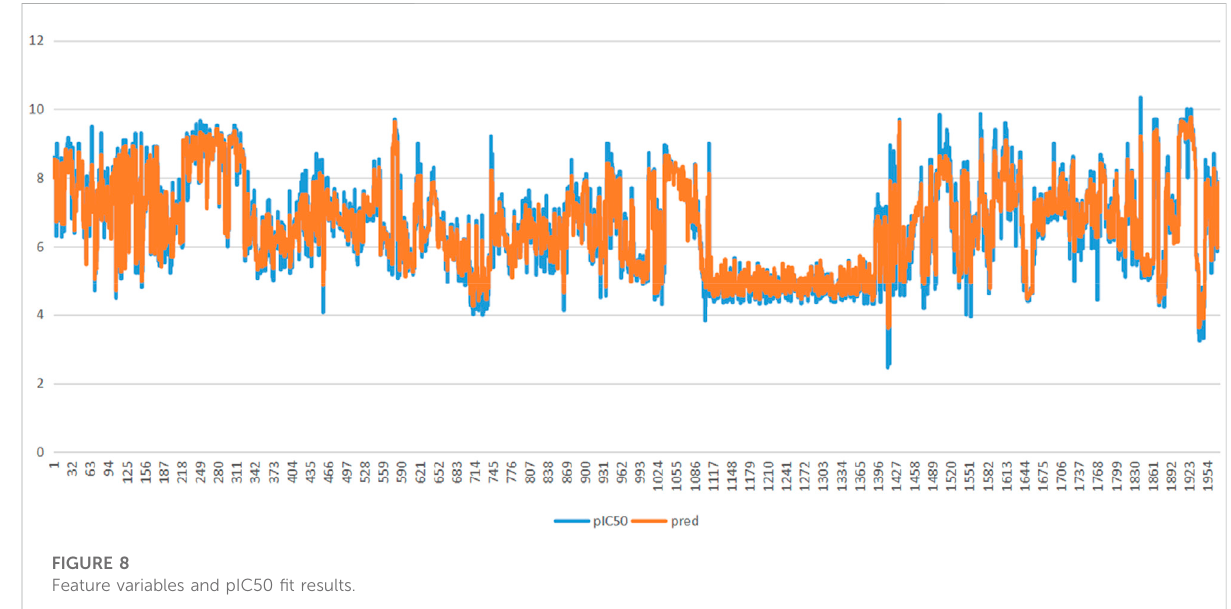
FIGURE 8 Feature variables and pIC50 fi t